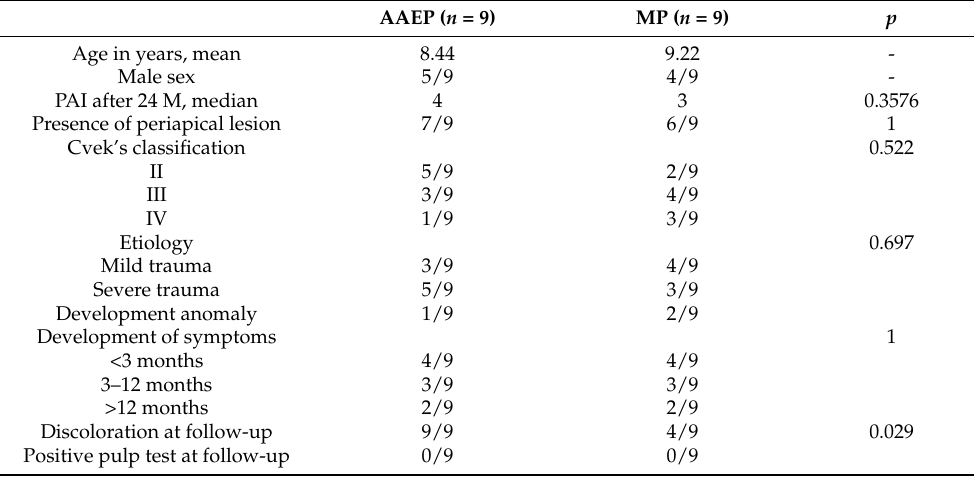
Table 1. Description of treatment group epidemiological characteristics. AAEP—protocol according American Association of Endodontists, MP—modified protocol, PAI—periapical